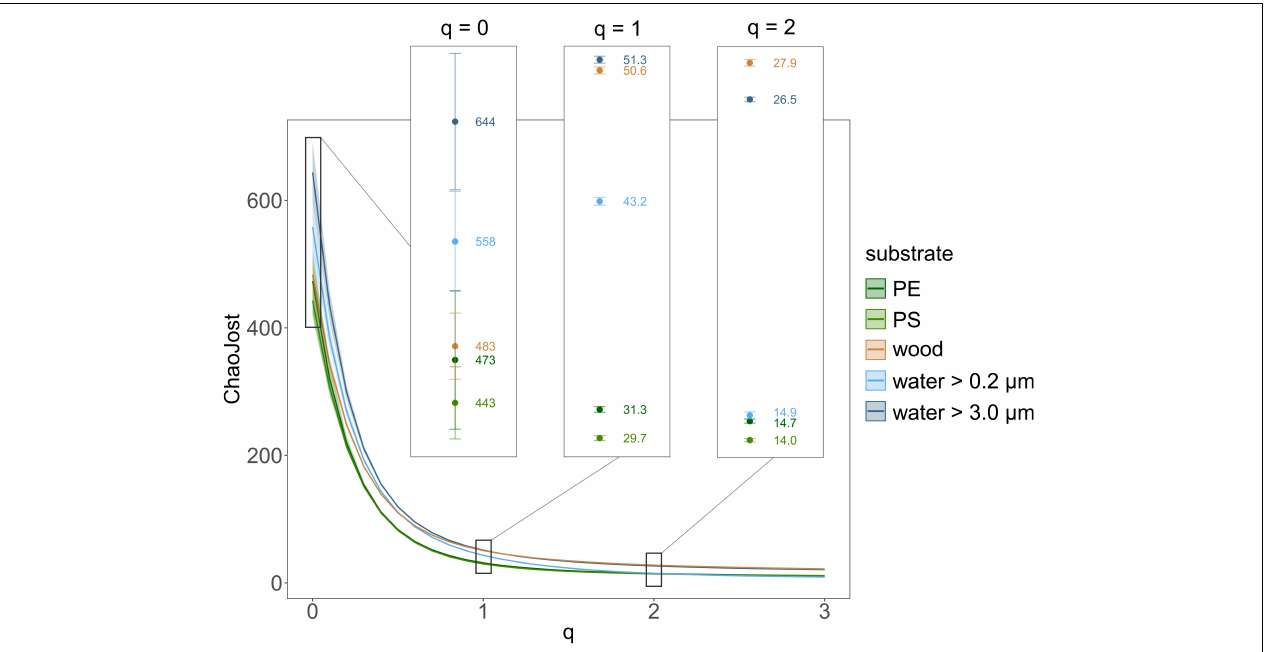
FIGURE 3 | Eukaryotic taxon diversity presented as continuous diversity profiles with 95% confidence intervals for the substrates PE, PS, and wood as well as the small (between 0.2 and 3.0 µ m) and large water size fraction ( > 3.0 µ m). Diversity estimator “ChaoJost” (as proposed by Chao and Jost, 2015) on the y -axis and diversity order q on the x -axis. Estimated richness ( q = 0), Shannon diversity ( q = 1, exponential of Shannon entropy) and Simpson diversity ( q = 2, inverse Simpson concentration) are enlarged in